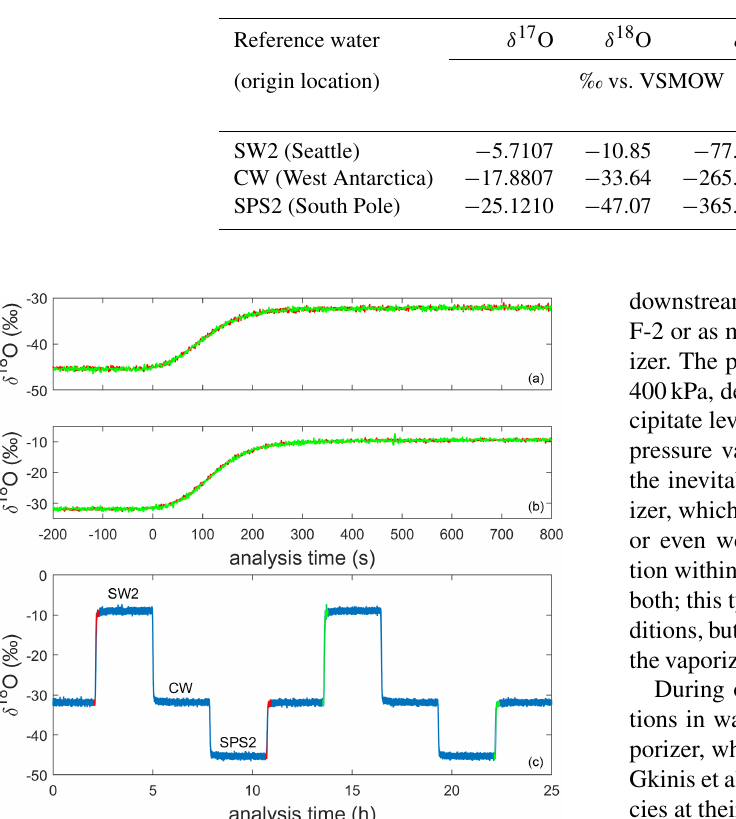
Table 1. Isotopic values of reference waters. SW2 is Seattle deionized tap water, CW is melt water from the WDC06A core (i.e., West Antarctic Ice Sheet precipitation), and SPS2 is South Pole snow. These three waters were normalized to the VSMOW-SLAP scale using other in-house reference waters that were analyzed against VSMOW, SLAP, and GISP. The calibrated δ 17 O values are calculated from the combination of (cid:49) 17 O and δ 18 O and are therefore reported to four significant digits (see Schoenemann et al., 2013, for additional details).